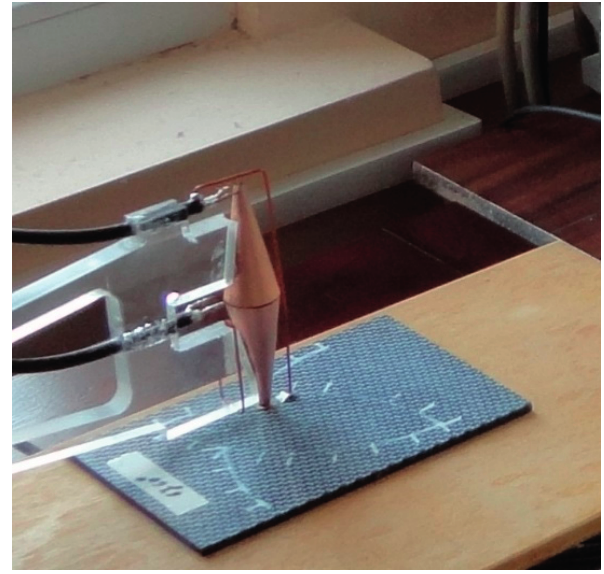
Figure 3. Design of device for